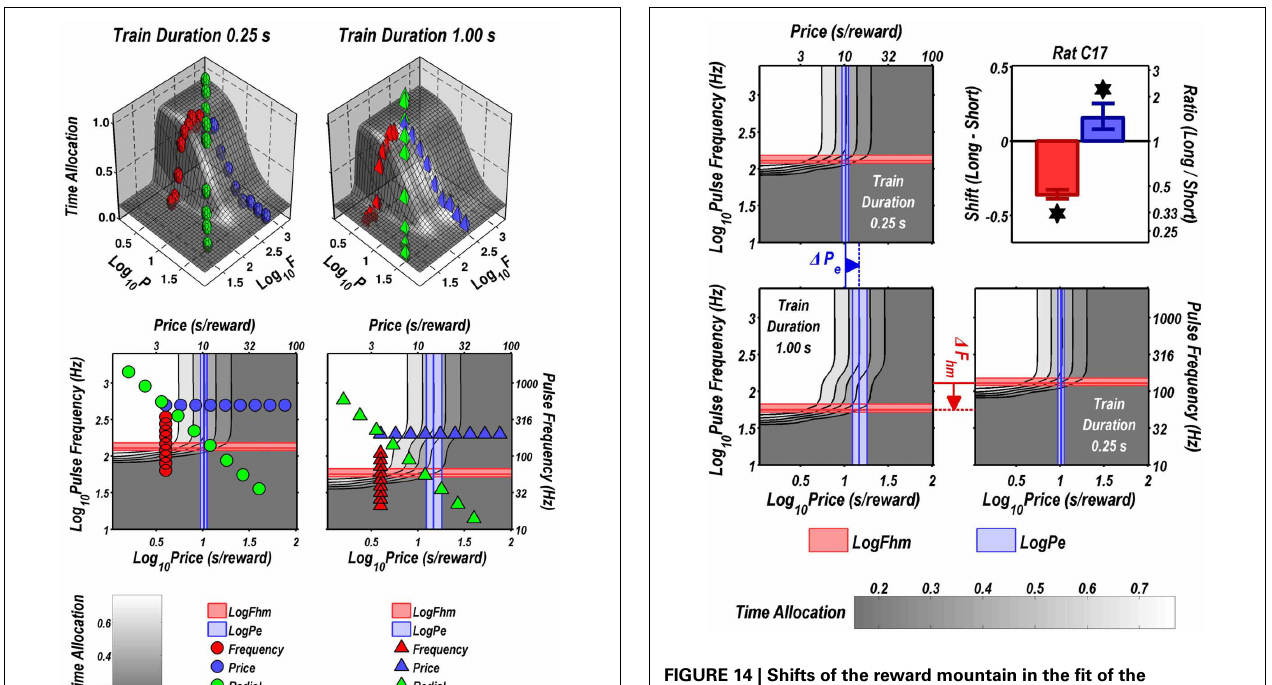
FIGURE 14 | Shifts of the reward mountain in the fit of the dual-integrator model to the data from rat C17. The contour graph for the long-duration (1s) train is shown in the lower left. For comparison the contour graph for the short-duration (0.25s) train is shown twice, in the upper left and lower right. For clarity, the sampling vectors (the series of points designating the pulse frequencies and prices tested) have been omitted. These can be seen in Figures 3 , 13 . For comparison with the fit of the single-integrator model to this same dataset, see Figure 3 . Note the wiggles in the contour lines for the longer train duration (lower left), which are due to the offset between the pulse frequencies over which reward intensity grows in the two integrators (upper and lower 3D graphs in Figure 12 ). The P e parameter determines the location along the price axis, whereas the F hm parameter determines the location of the mountain along the pulse-frequency axis. The vertical blue line represents the estimate of P e , and the surrounding band represents the corresponding 95% confidence interval. The horizontal red line represents the estimate of F hm , and the surrounding band represents the corresponding 95% confidence interval. The bar graph shows the mean shifts in the location parameters due to the increase in train duration from 0.25 to 1s. As this figure shows, the dual-integrator model can account for the observed shift of the mountain rightward along the price axis when the train duration is increased from 0.25 to